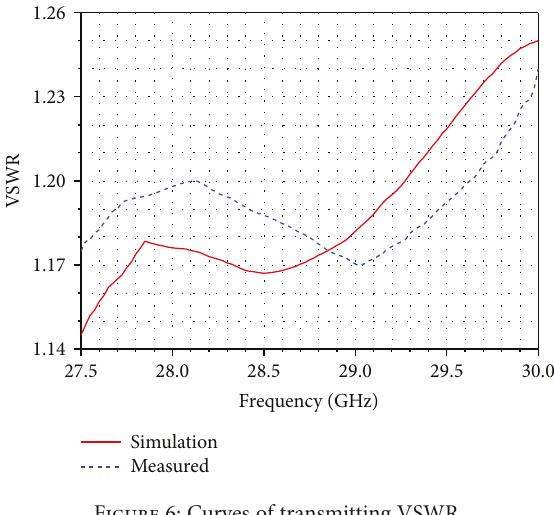
Figure 6: Curves of transmitting VSWR.